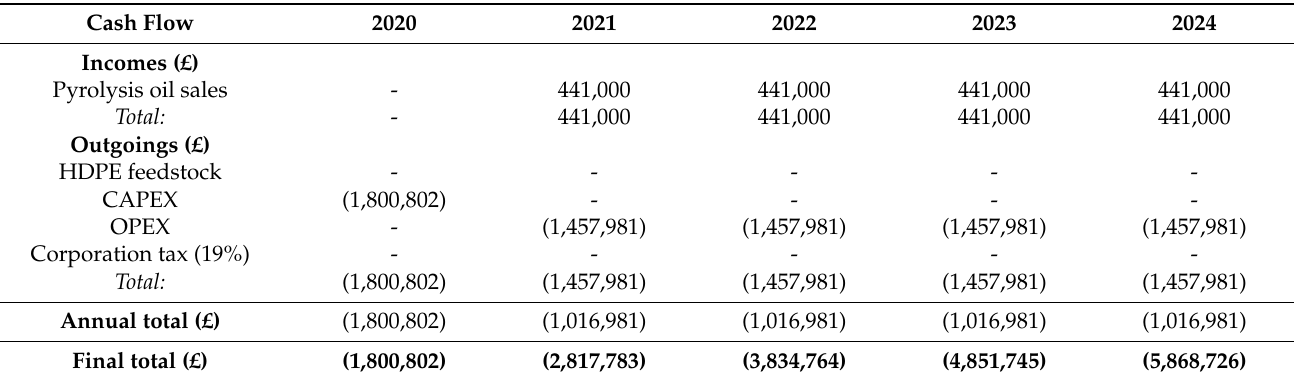
Table 5. Cash flow statement for conversion process of HDPE to pyrolysis oils at a feed rate of 100 kg/h and a sale price of